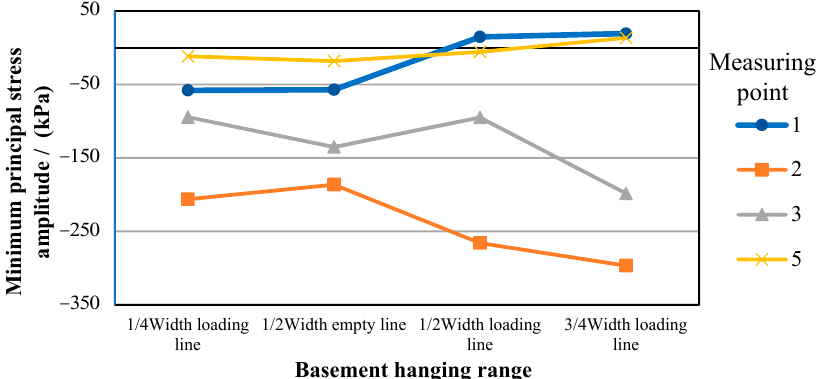
Figure 19. Minimum principal stress increment amplitude diagram of measuring points 1, 2, 3, and 5 under different basement hanging ranges. Table 16. Minimum principal stress amplitude of measuring points 1, 2, 3, and 5 under different basement hanging ranges.